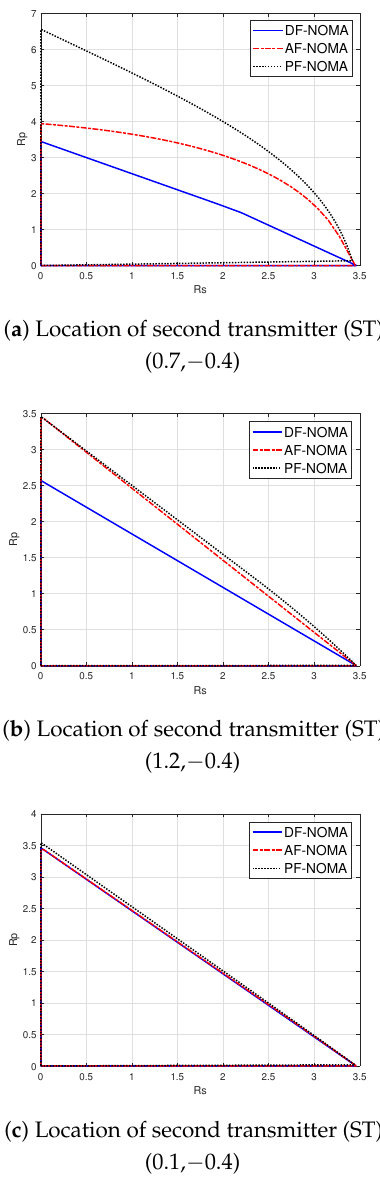
Figure 4. Achievable rate at the secondary receiver ( R s ) versus achievable rate at the primary receiver ( R p ) for PF-NOMA, AF-NOMA, and DF-NOMA schemes at different locations of the secondary